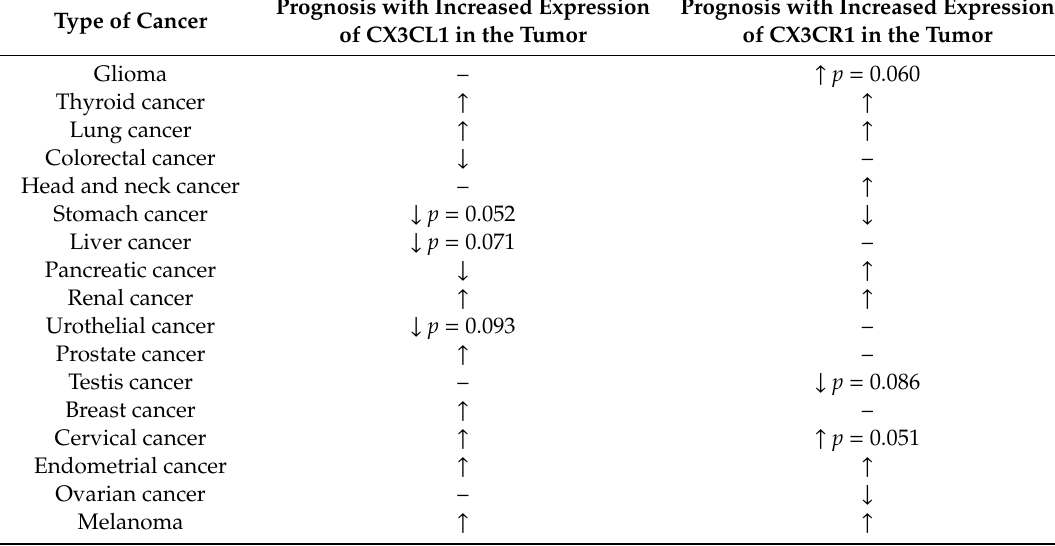
Table 2. Prognosis for various types of cancer with increased expression of CX3CL1 or CX3CR1 according to The Human Protein Atlas